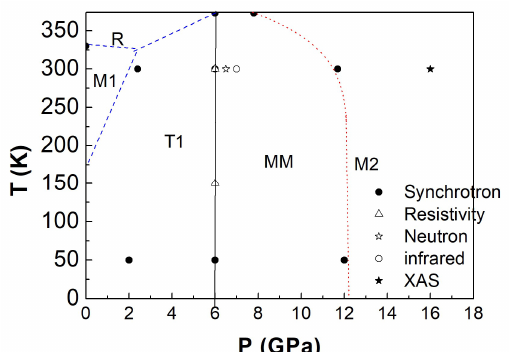
Figure 15. Pressure dependence of the LuFe 2 O 4. The R ( R 3 m , M1 ( C 2/ m ) and T1 (proposed smooth